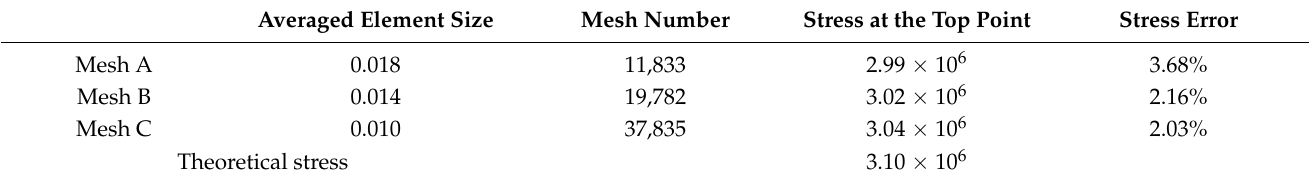
Table 2. Stress results at the top point in the three meshes and errors with respect to the theoretical value. Averaged Element Size Mesh Number Stress at the Top Point Stress Error Mesh A 0.018 Mesh B 0.014 Mesh C 0.010 Theoretical